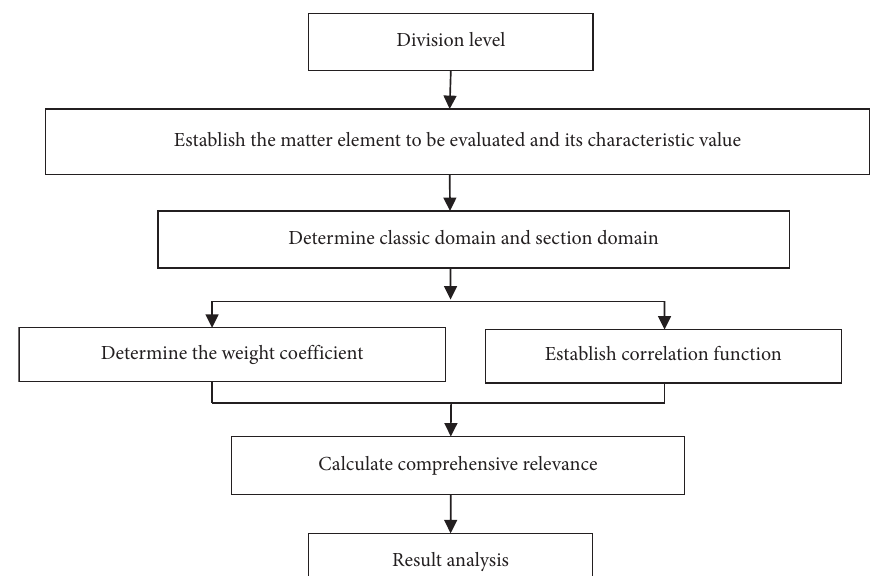
Figure 2: Evaluation process of extension evaluation method.